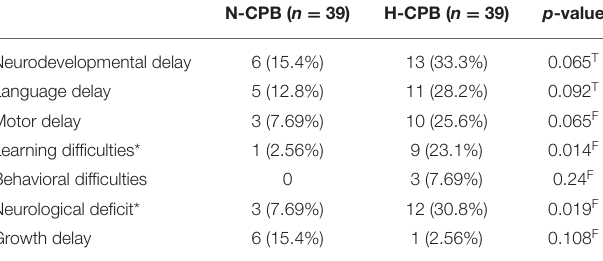
TABLE 3 | Neurodevelopmental outcomes of the analysis cohort. N-CPB ( n = 39) H-CPB ( n = 39) p -value Neurodevelopmental